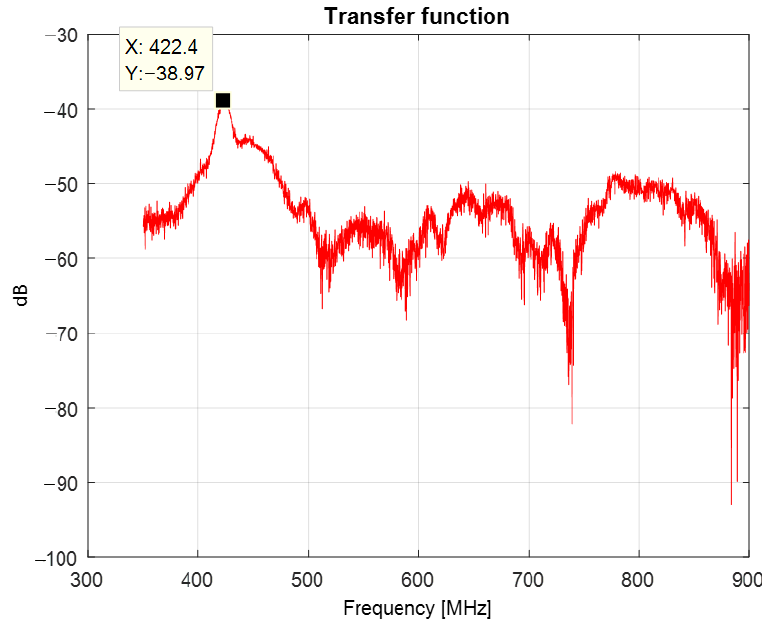
Figure 23. Transfer function of the system consisting of the antenna and its image. Figure 24 shows the VSWR as a function of frequency; a minimum of 1.33 is attained at 422.4 MHz.